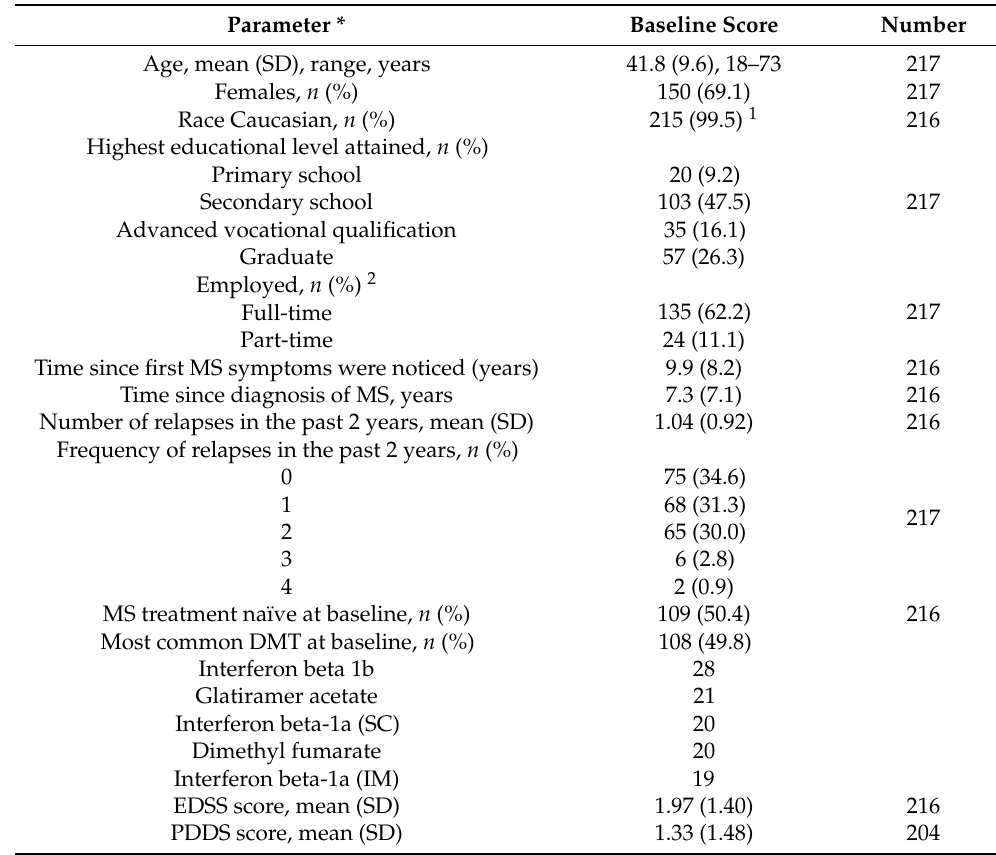
Table 1. Baseline characteristics of the Teri-REAL patient cohort (ASCP) †